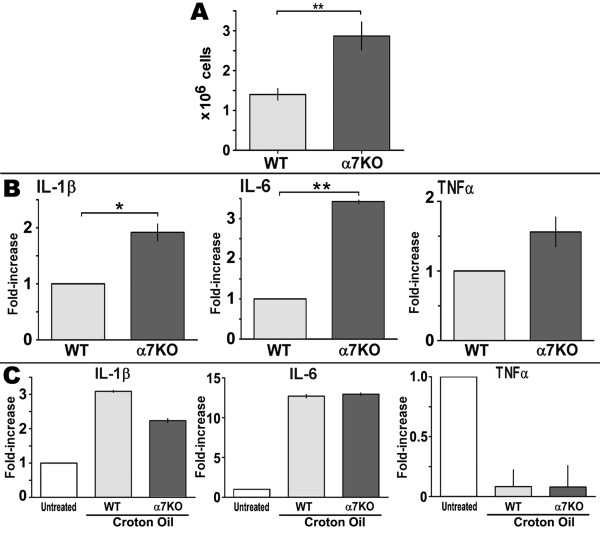
The local inflammatory response to croton oil is enhanced in the α7KO mouse. Ears of WT and α7KO mice (5 animals/experiment) were treated with croton oil. Six hours post-treatment ears were removed, dorsal and ventral halves separated before floating them dermis side down on media overnight. A) Total number of cells isolated per treatment group was then measured (99% viability, not shown). The light grey bars represent WT mice and dark grey bars the α7KO. Error bars reflect ± of the standard error of the mean of all experiments (3-5 experiments per group); * p < 0.05 and **, p < 0.01 (two-tailed Student's T-test). B) Expression of key pro-inflammatory cytokine transcripts from infiltrating cells using qPCR (Methods). The average fold increase normalized to a value of 1 for IL-1β, IL-6 and TNFα from α7WT mice (light grey) and α7KO (grey bars) are compared. Error bars reflect the standard error of the mean from 3 independent experiments with 5-6 mice per experimental group. C) Analysis of transcripts from ear skin after removal of infiltrating cells from untreated mice, or mice treated with croton oil. The expression of these cytokines does not differ between α7WT and α7KO. Light gray bars represent ear skin from WT mice and dark gray for α7KO mice. Non-shaded bars represent ear skin from untreated WT mice. Ear skin RNA amounts recovered did not differ between genotypes (not shown).